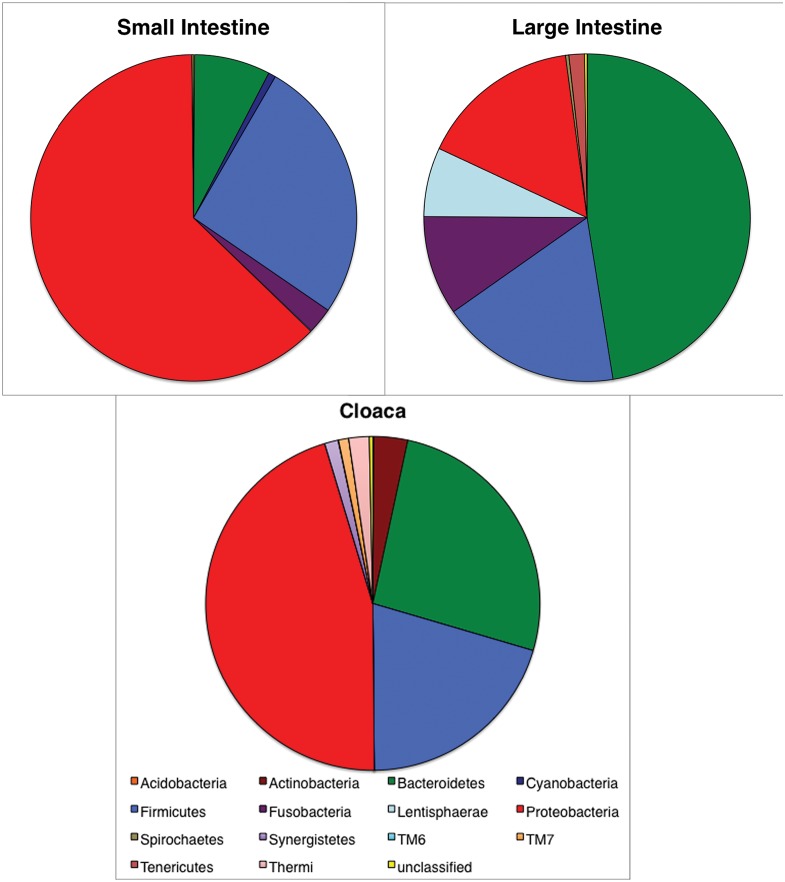

Agkistrodon piscivorus GIT bacterial abundance.Relative abundance of major bacterial lineages found in various regions of the gastrointestinal tract of all Agkistrodon piscivorus as identified 16S rRNA gene pyrosequencing. Proportions represent the proportion of 454 sequence reads classified as being in that taxon (number of reads ranges from 5,620–14,905).